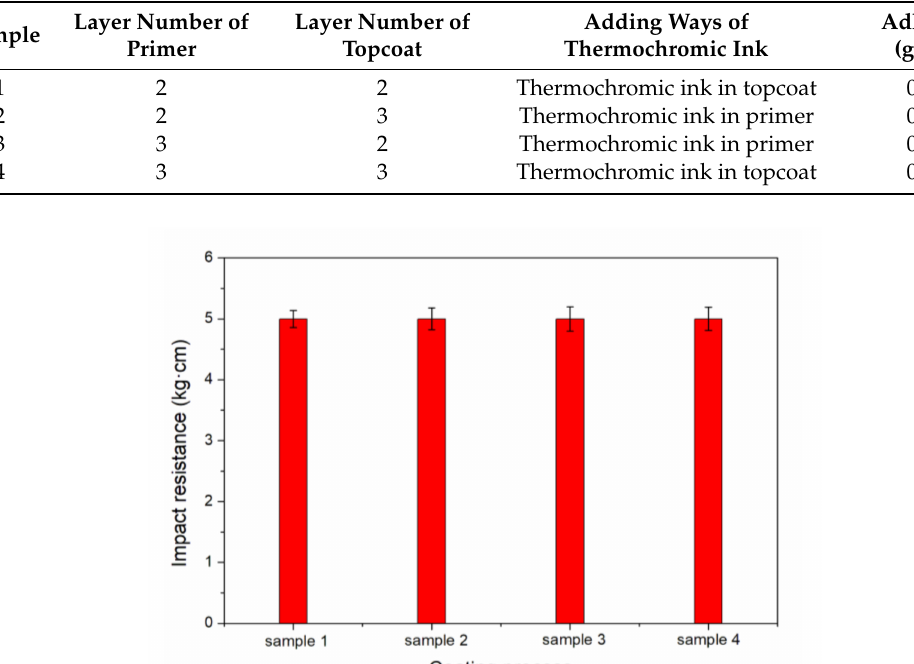
Figure 5. The impact resistance of waterborne coating on Chinese fir (samples 1–4 from Table 1).